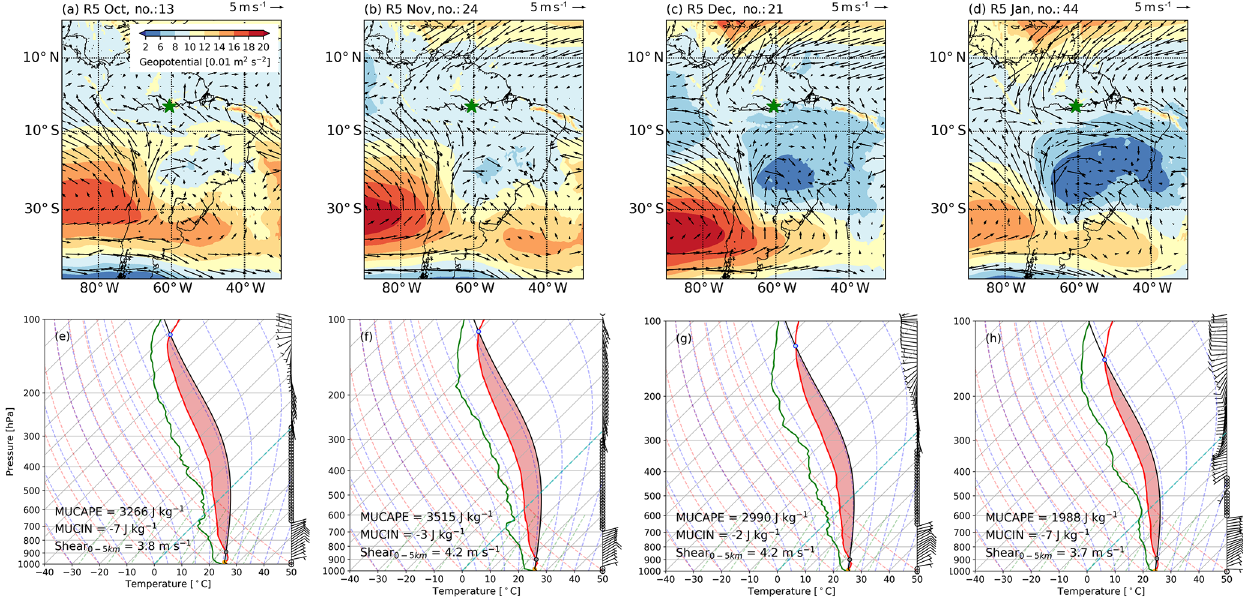
Figure 6. Composite, monthly, large-scale synoptic patterns at 1000hPa (following Fig. 5) and radiosondes associated with regime 5. Plots correspond left to right to (a) October, (b) November, (c) December, and (d) January.